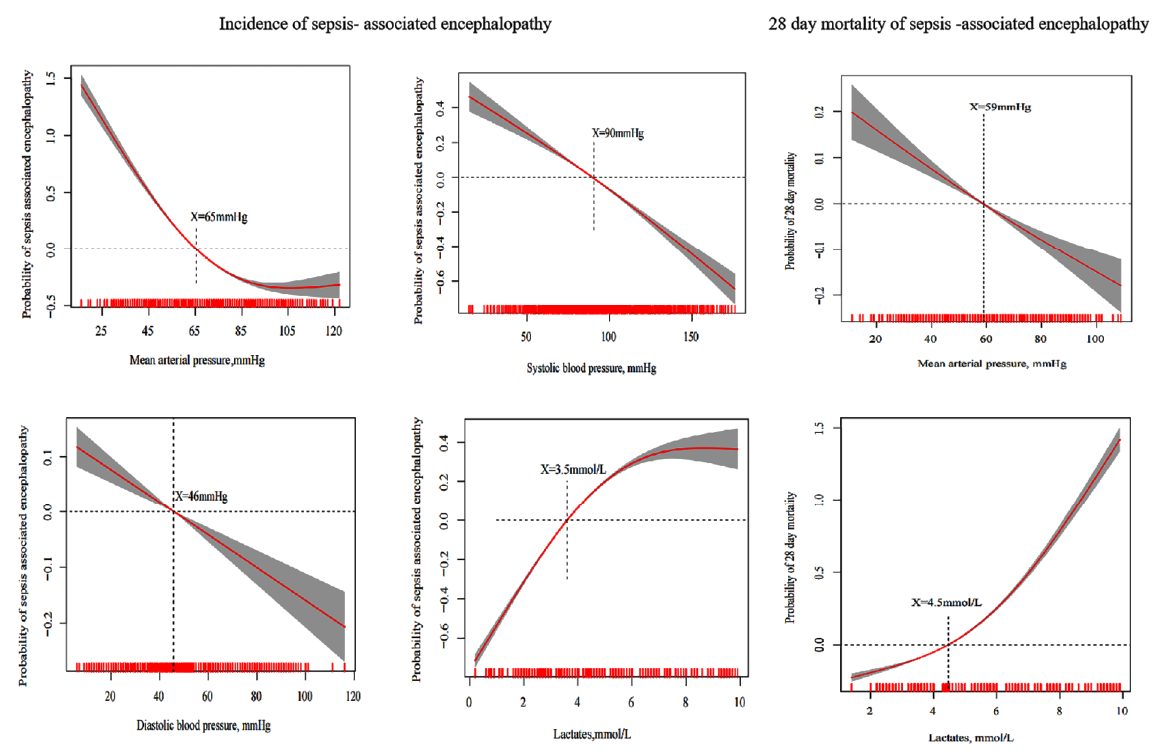
Figure 3. Generalized additive model evaluates the relationship between hemodynamic parameters and the incidence and 28-day mortality in sepsis-associated encephalopathy. Table 2. Multiple models analysis of hemodynamic index to incidence in sepsis with encephalopathy.